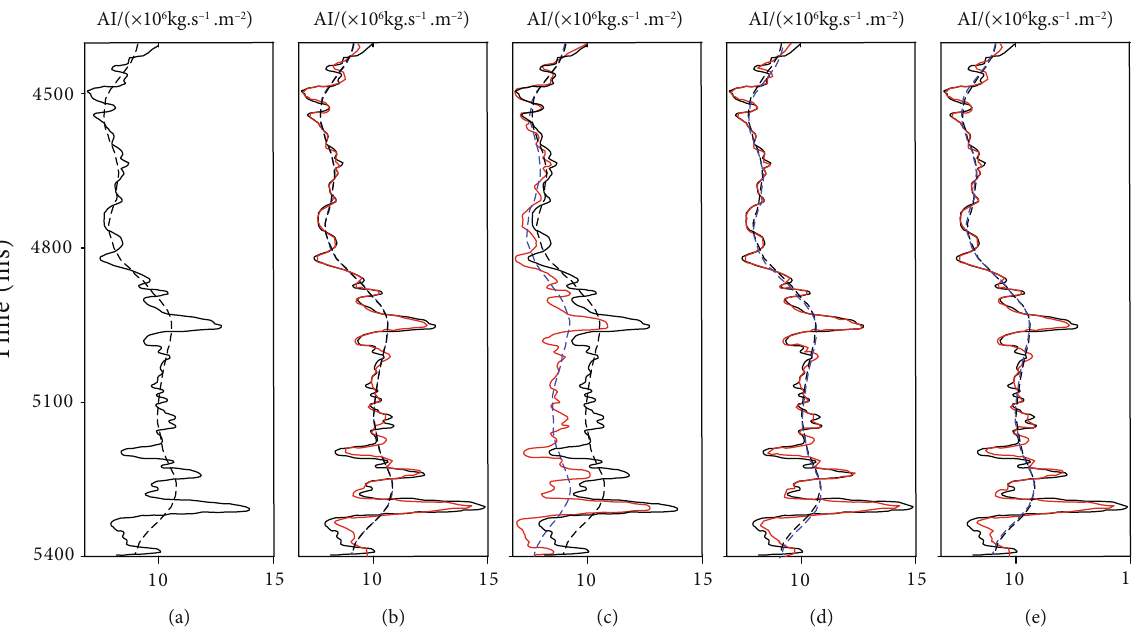
Figure 1: (a) The well logging curve of the study area (black solid line for the well curve, dotted line for its low-frequency components). (b) and (c) represent the smooth regular constrained inversion with a value of 10 -3 and 10 -7 , respectively (black solid line for the well curve, black dotted line for its low-frequency components; red solid line for the inversion results, blue dotted line for its low-frequency components). (d) and (e) represent the facies-controlled constrained inversion result with facies weight values of 10 3 and 10 6 , respectively (black solid line for the well curve, black dotted line for its low-frequency components; red solid line for the inversion results, blue dotted line for its low-frequency